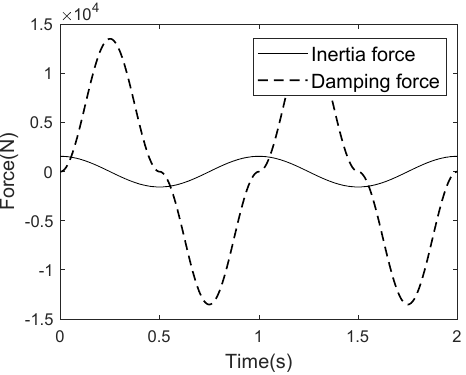
Figure 7. The curve of damping and inertia force over time of a single-cylinder fluid inerter. As can be seen from Figures 8 and 9, the maximum damping force of a dual-cylinder fluid inerter is 40.32% (5451/13,519 = 0.4032) of that in a single-cylinder fluid inerter, and the inertia force is 180.96% (2823/1560 = 1.8096). Figure 8. The comparison curve of damping force and velocity.